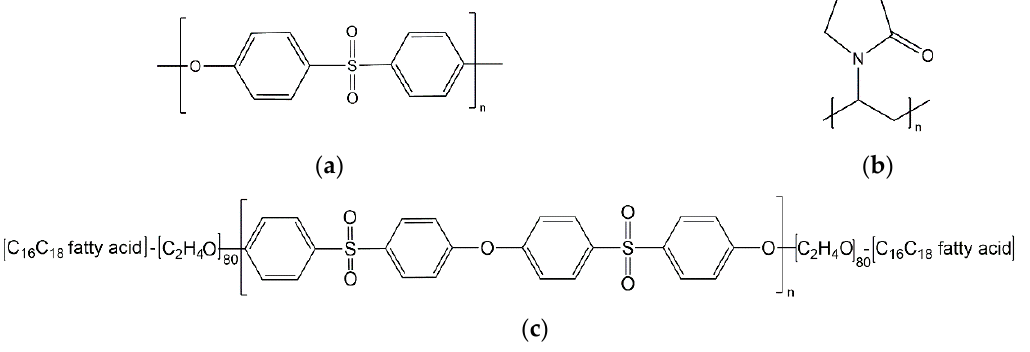
Figure 1. Chemical structure of ( a ) Poly(ether sulfone) (PESU); ( b ) Poly( N -vinyl pyrrolidone) (PVP); ( c ) Triblock copolymer PEO-PESU-PEO.